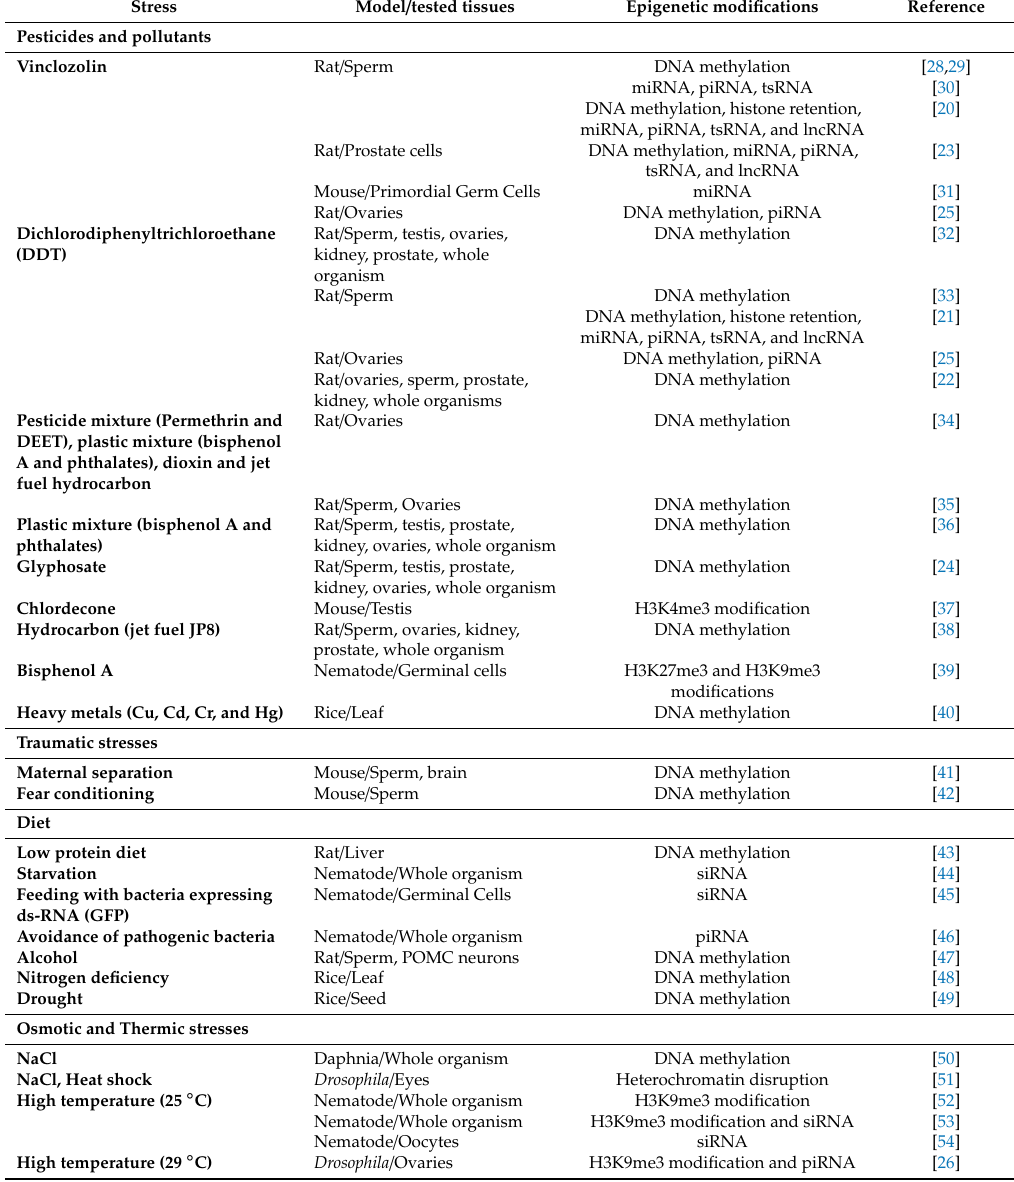
Table 1. A list of environmentally-induced transgenerational epigenetic